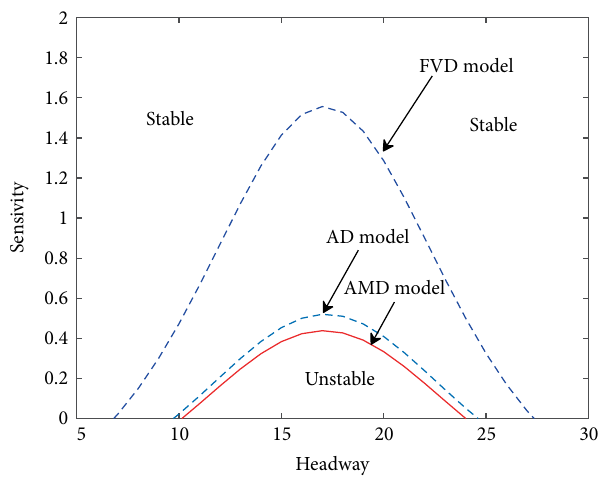
Figure 2: The neutral stability line in the headway-sensitivity